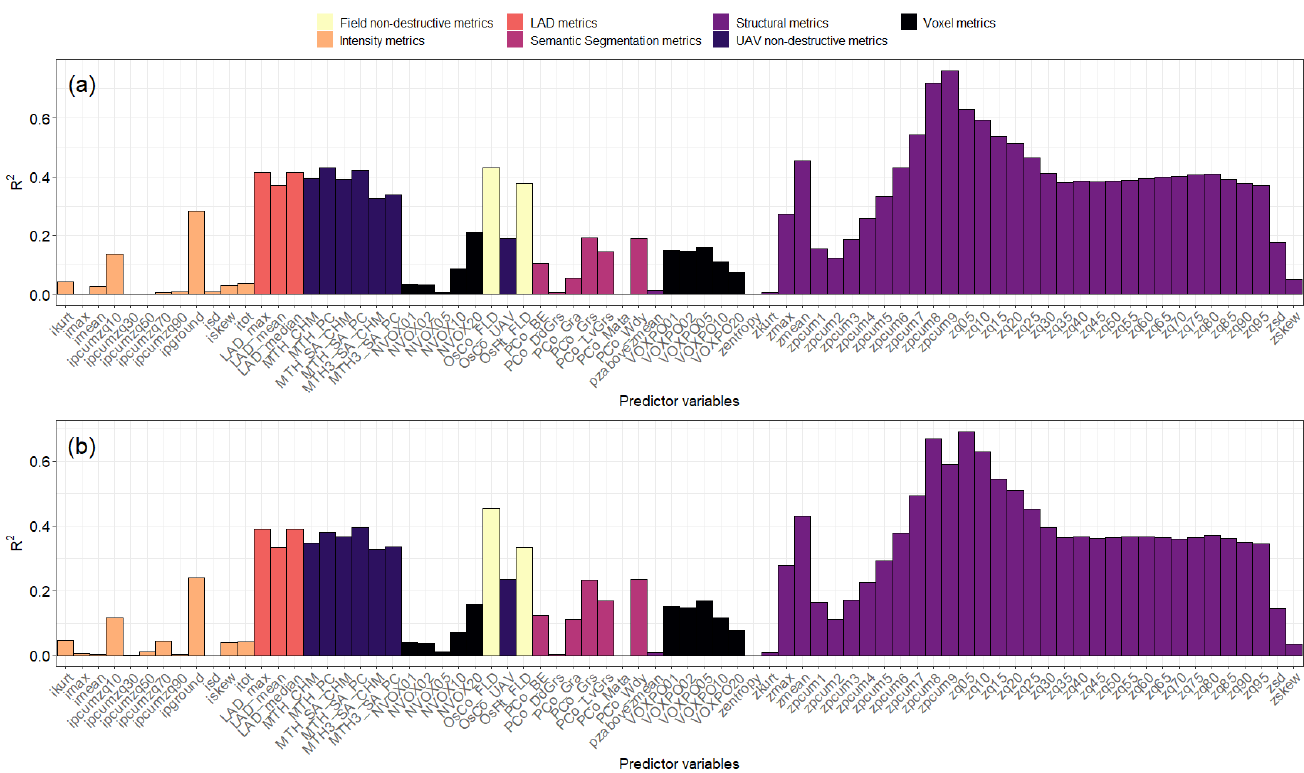
Figure 6. Performance of the lidar and field-measured metrics in predicting ( a ) TAGB and ( b ) AGAF, coloured by the type of predictor variable.